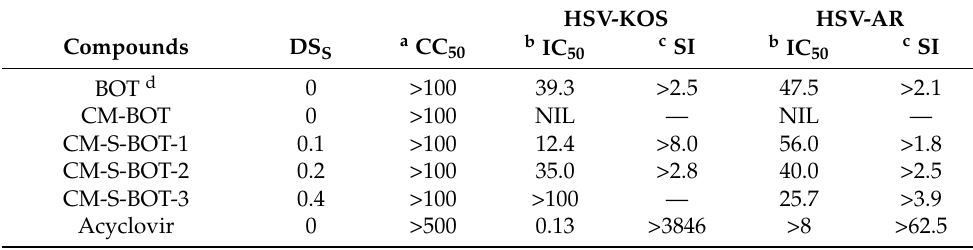
Table 1. The degrees of substitution (DSs) and antiviral activity of carboxymethylated BOT (CM-BOT) and its sulfonated derivatives (CM-S-BOT-1-3) against herpesvirus (KOS and AR strains). HSV-KOS HSV-AR Compounds DS S a CC 50 b IC 50 c SI b IC